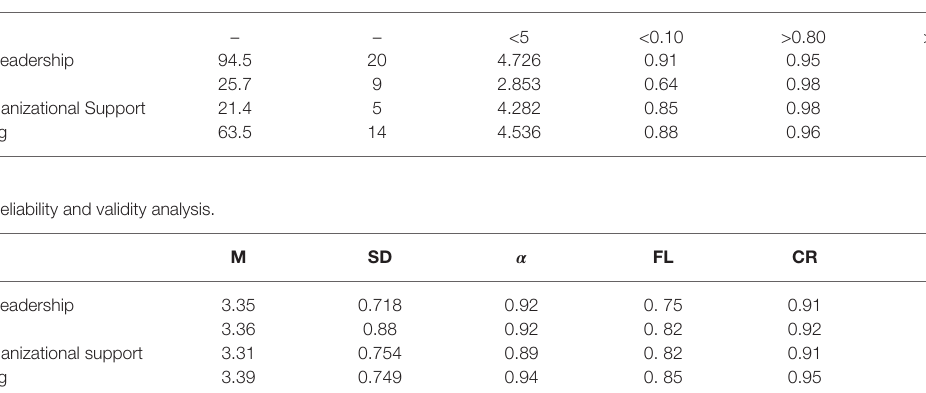
TABLE 1 | First-order CFA. Construct